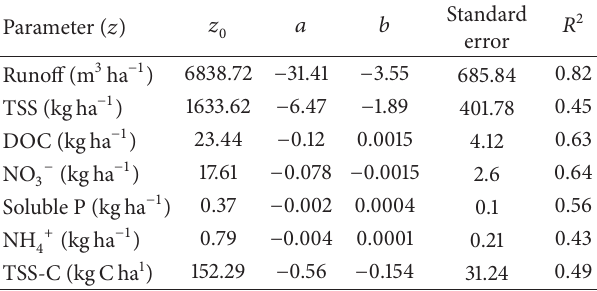
Table 4: Constants, standard error, and coefficients of variation of the regression